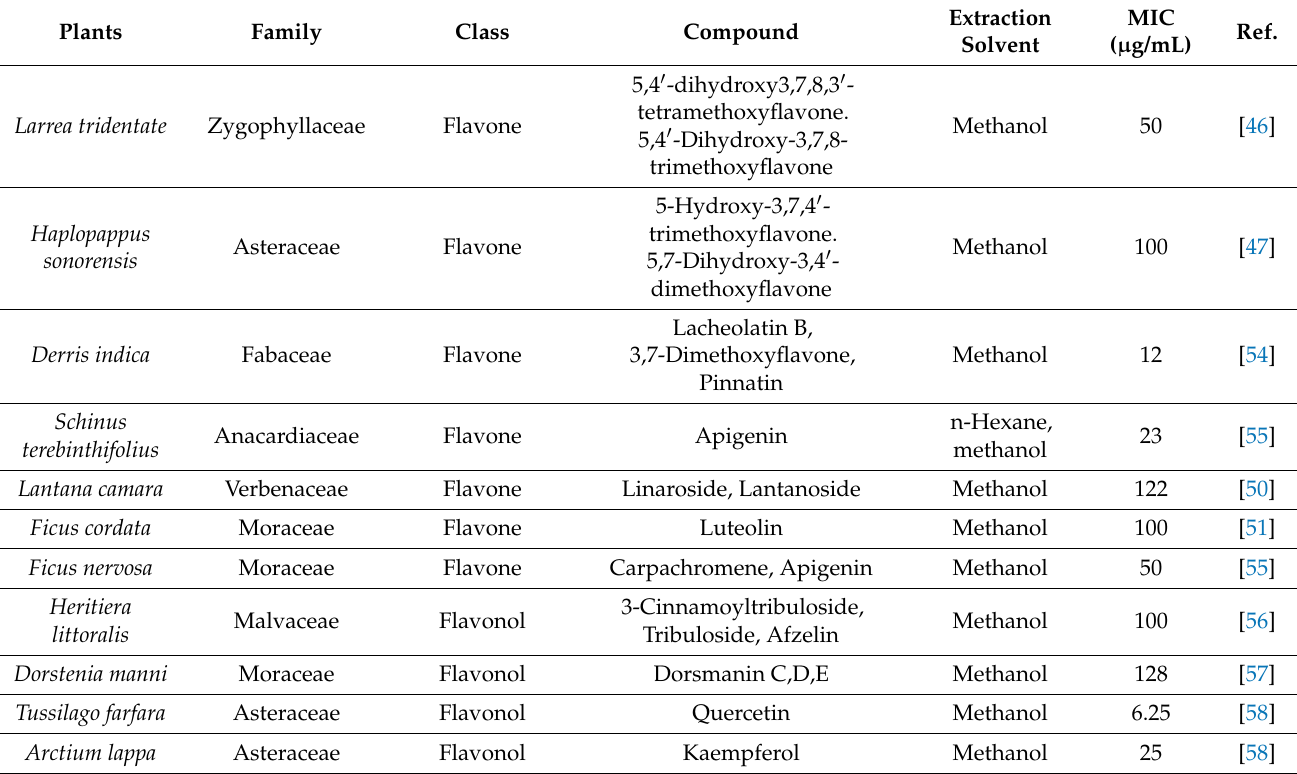
Table 1. List of anti-tuberculosis flavones and flavonols extracted from various